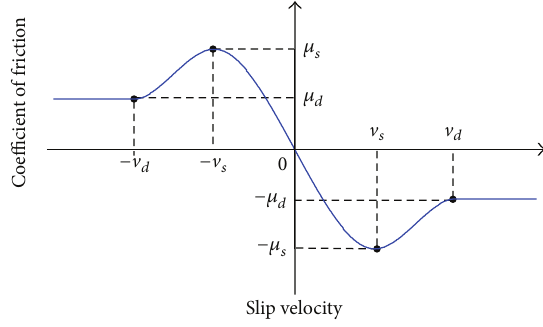
Figure 6: Coefficient of friction versus slip